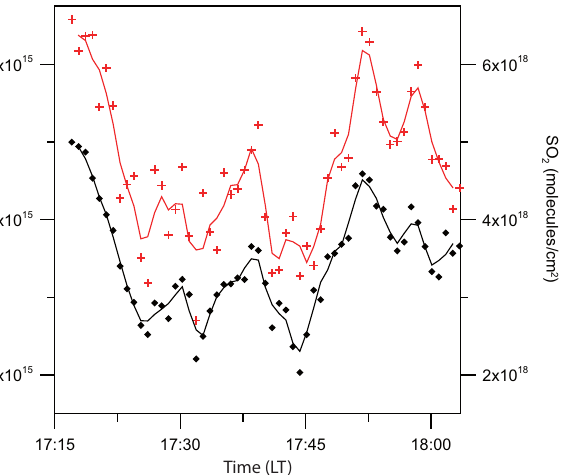
Fig. 14. Time series of the SO 2 (black diamonds) and SiF 4 (red crosses) slant columns obtained from thermal emission spectra recorded at 0.5cm − 1 resolution on 17 November 2008.